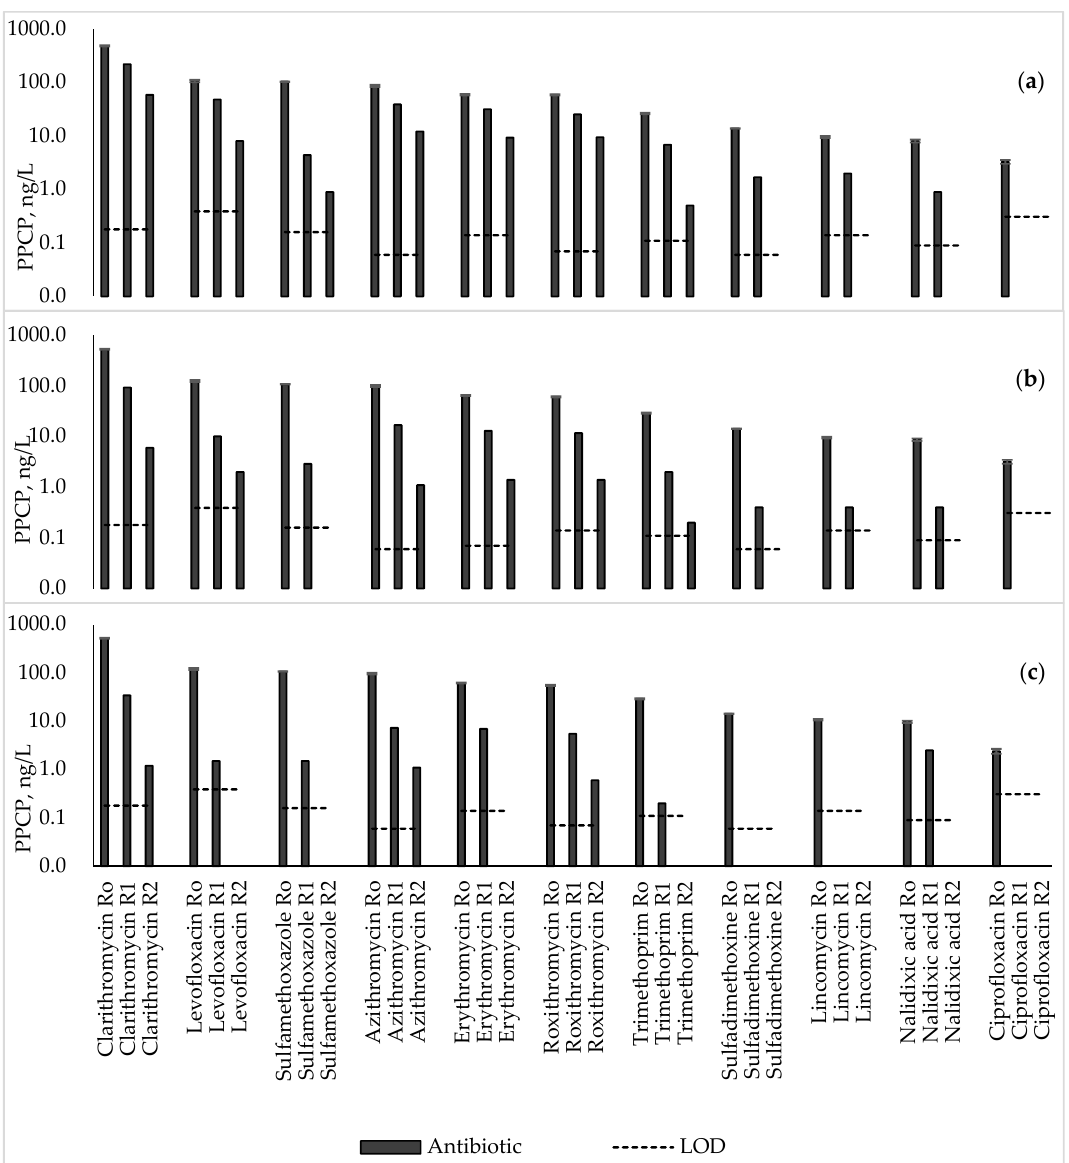
Figure 2. Concentrations of 11 antibiotics in the feed secondary effluent (R o ) and effluent of the R 1 and R 2 reactors at the O 3 doses of: ( a ) 1 and 2 mg L − 1 , respectively, in Run 1; ( b ) 2 and 4 mg L − 1 , respectively, in Run 2; and ( c ) 3 and 6 mg L − 1 , respectively, in Run 3. PPCP: personal care products.